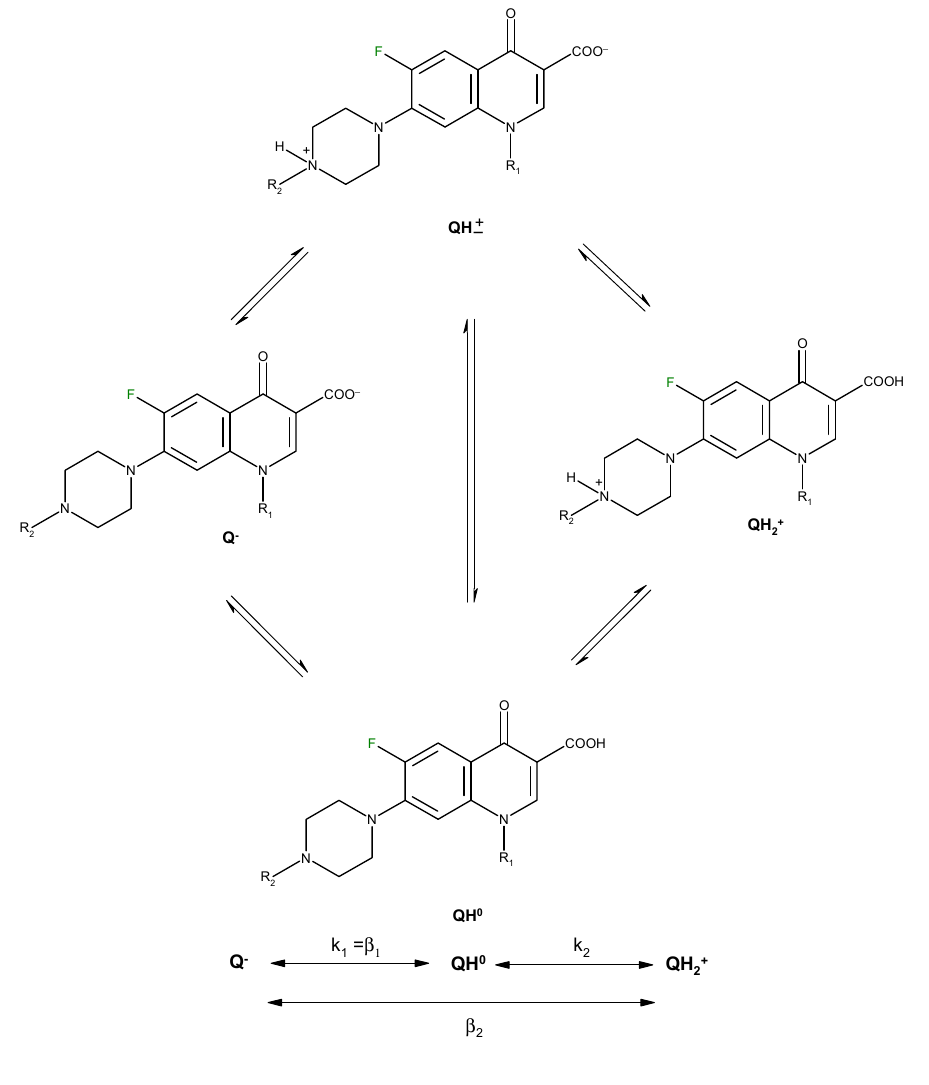
Figure 3. Protonation scheme of a fluoroquinolone molecule with piperazine ring at the 7-position (adapted from